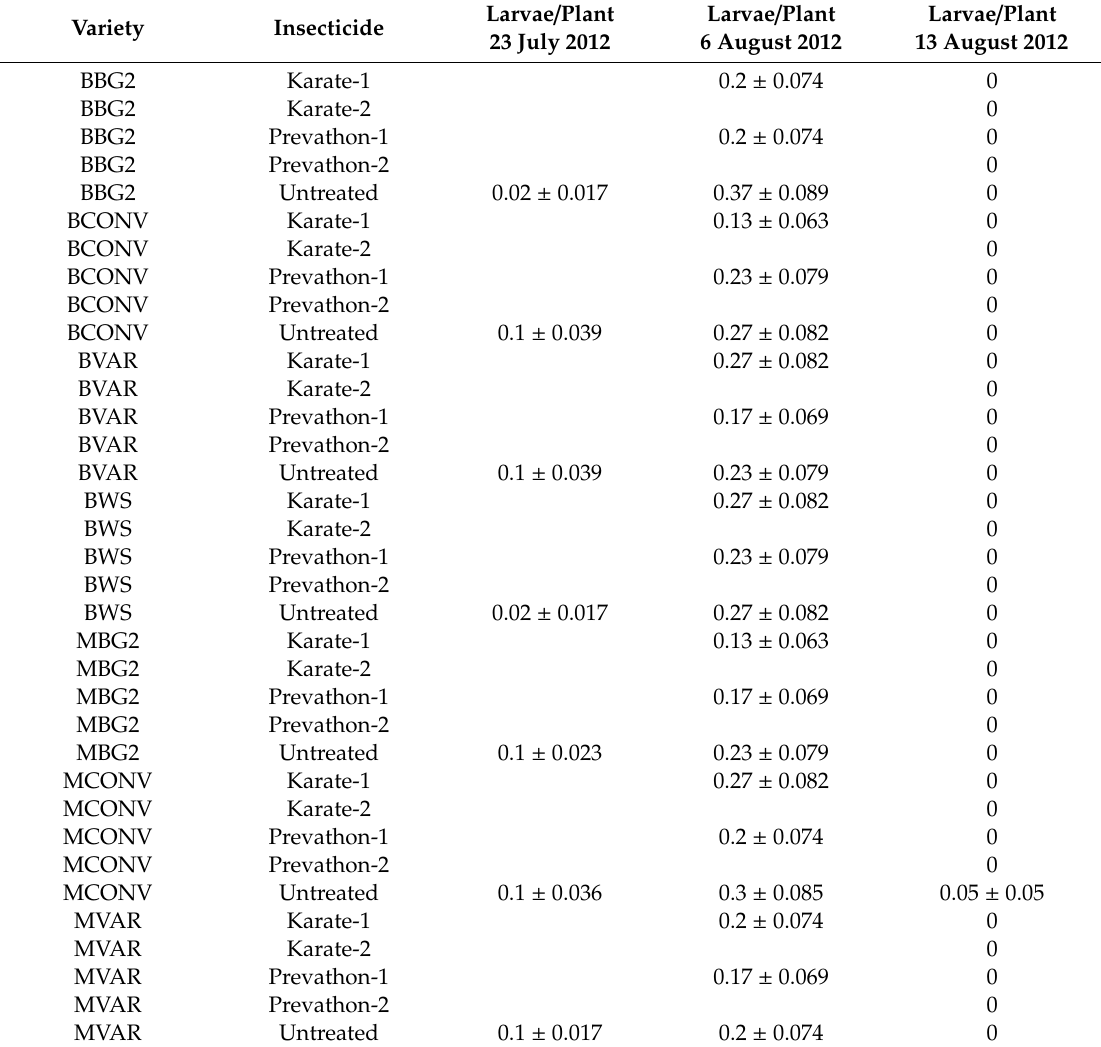
Table 4. Mean larval densities ± SEM observed in cage study plots in